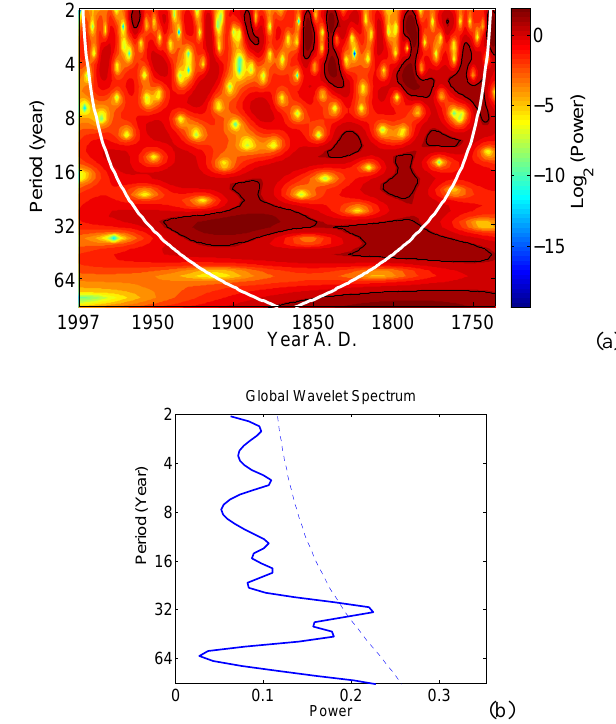
Fig. 7. (a) Wavelet plot for δ D: binary logarithm of the power (ab- solute square of the wavelet transform) in ‰ 2 . Black contours rep- resent the 95% confidence level against red noise (Torrence and Compo, 1998). Areas outside the cone of influence (indicated by the thick white line) are to be discarded. (b) Global wavelet spec- trum for δ D. The thin dashed line indicates the 95% confidence level against red noise.